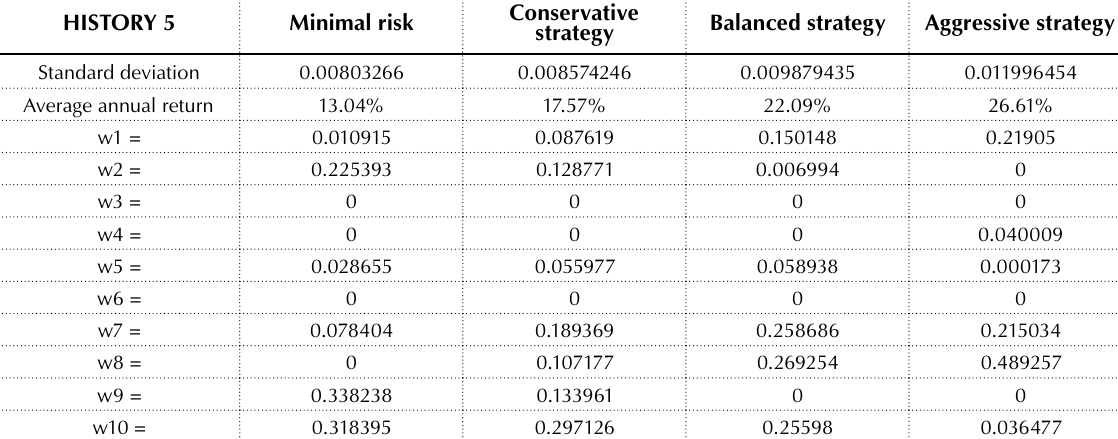
Table 3. Results analysis for the 5-year historical yield